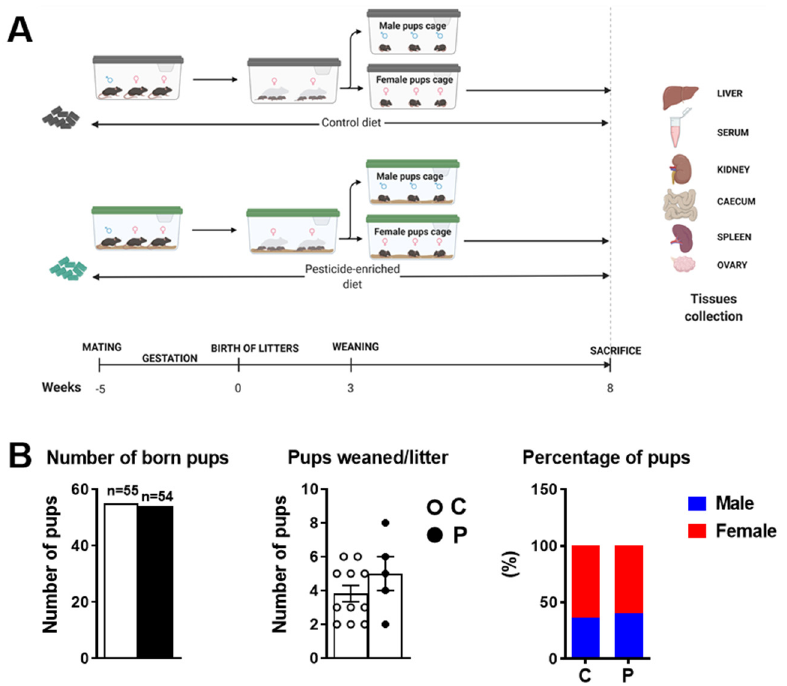
Figure 1. ( A ) Experimental timeline: 20 C57Bl/J female mice (F0) were fed a pesticide-enriched ( n = 13) or a pesticide-free ( n = 13) normal diet from mating to the end of lactation. At the end of mating, 11 control F0 females and 5 females exposed to pesticides were pregnant. After weaning, male and female pups (F1) were separated, and only female pups were fed the same diet as their mother until 8 weeks of age. F1 female mice were sacrificed at 8 weeks of age. ( B ) Litter size and gender ratio in F1 female mice. Data are presented as mean ± SEM.